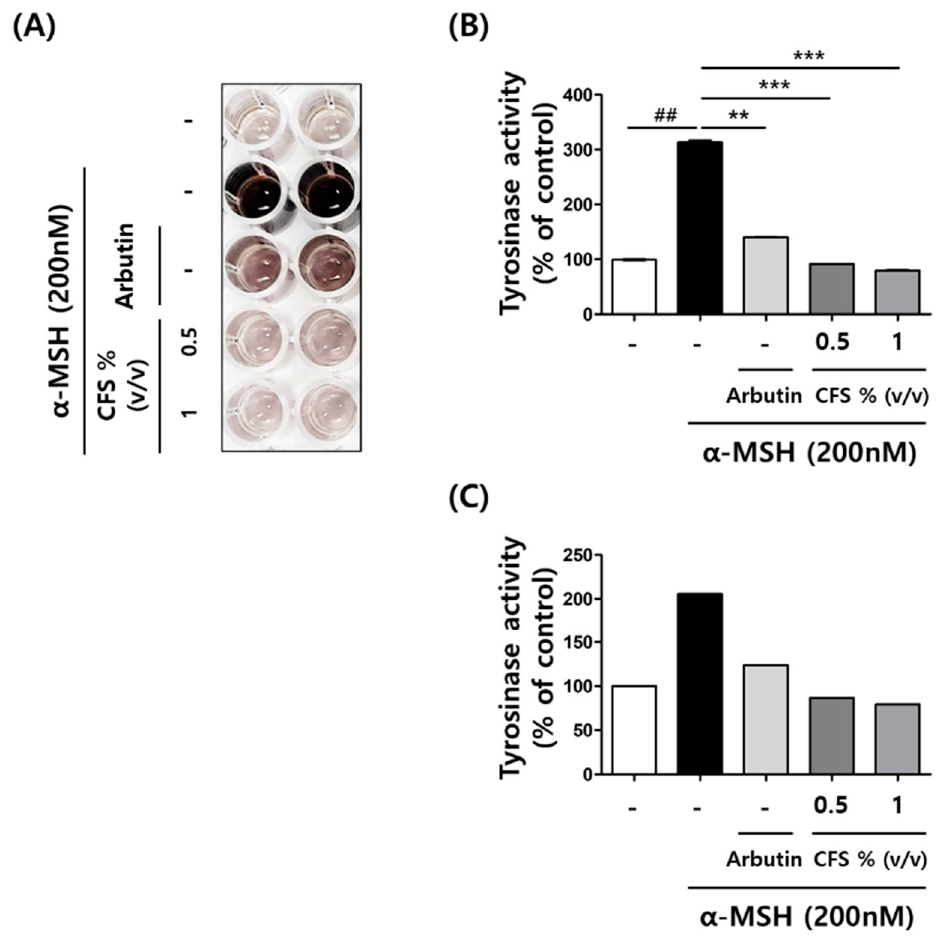
Figure 4. Effect of CFS on intracellular tyrosinase activity in B16-F10 cells. The tyrosinase activity levels were determined as described in the Materials and Methods. ( A ) The color of the tyrosinase activity after 40 h treatment of α -MSH, arbutin, and CFS. Intracellular tyrosinase activity was assayed using DOPA activity ( B ) and enzyme activity assay kit ( C ) in the extracted protein samples. CFS: cell-free supernatant from L. gasseri BNR17. Values represent the mean ± SD of three independent experiments. ## p < 0.01 compared with control. ** p < 0.01 and *** p < 0.001 compared with the α -MSH-treated control.